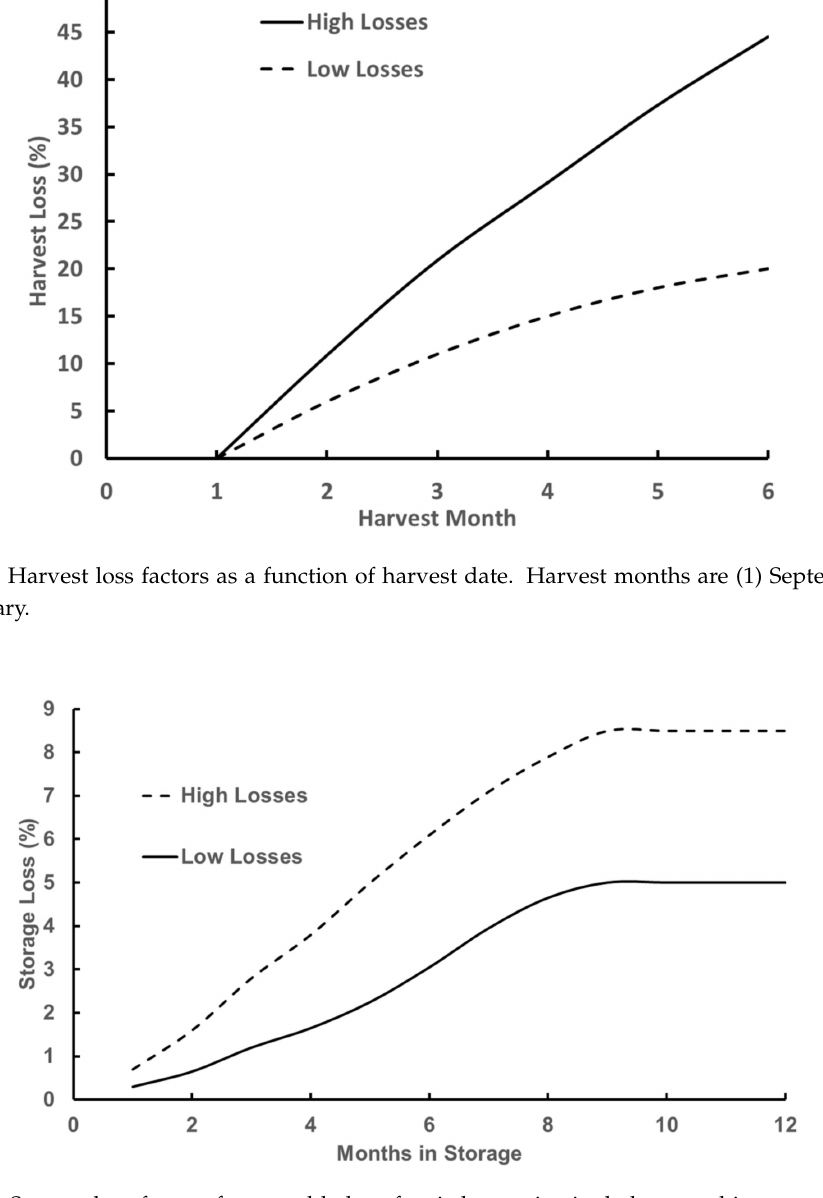
Figure 4. Storage loss factors for round bales of switchgrass in single-layer ambient storage on a gravel